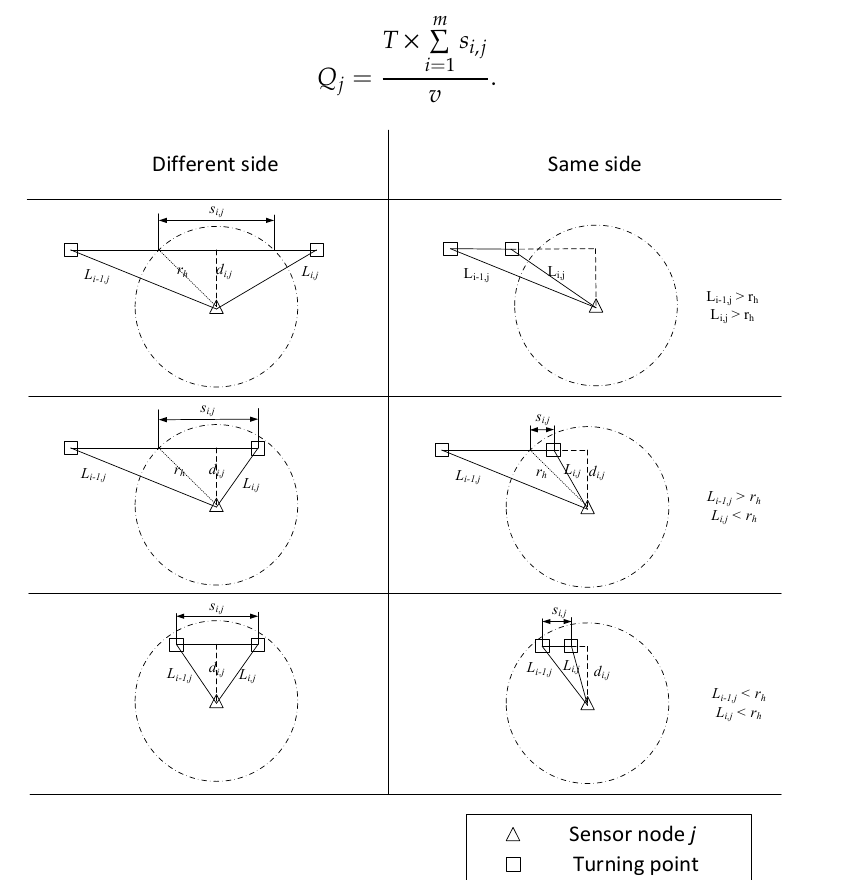
Figure 1. Six conditions where flight line segment i may pass through the efficient communication range of sensor node j , which depend on the efficient communication radius r h and the distances from the sensor node to the first and second turning points of the line segment ( L i − 1, j and L i , j ).